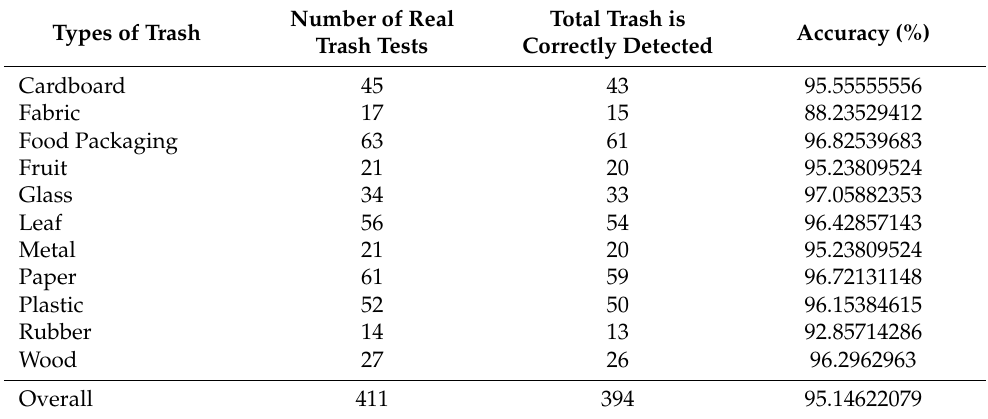
Table 9. The Accuracy of 11 Types of Trash Using a Real-Time Camera with Pre-Trained ResNet18.